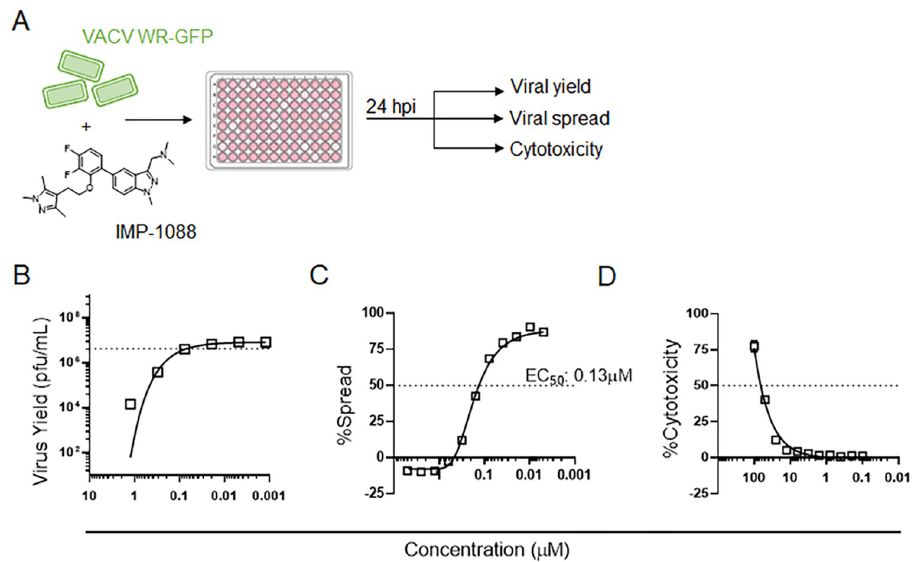
Fig 1. IMP-1088 inhibits VACV spread and virus yield. (A) Step-wise illustration of virus yield, spread and cytotoxicity assays. (B) Quantification of VACV yield in the presence of IMP-1088. HeLa cells were infected with VACV WR at increasing concentrations of IMP-1088. The cells were harvested 24 hpi, lysed by freeze-thaw and virus yield was determined by plaque assay. Dotted line indicates 50% virus yield. (C) Measuring viral spread in the presence of IMP-1088 based on GFP expression. Cells were infected with VACV WR-GFP in the presence of different concentrations of IMP-1088. The concentration of IMP-1088 required to reduce viral spread by 50% (EC 50 ) was determined. (D) Cytotoxic effects of IMP-1088 determined by LDH assay. All experiments were performed twice with two replicates in each experiment. Values represent means +/-